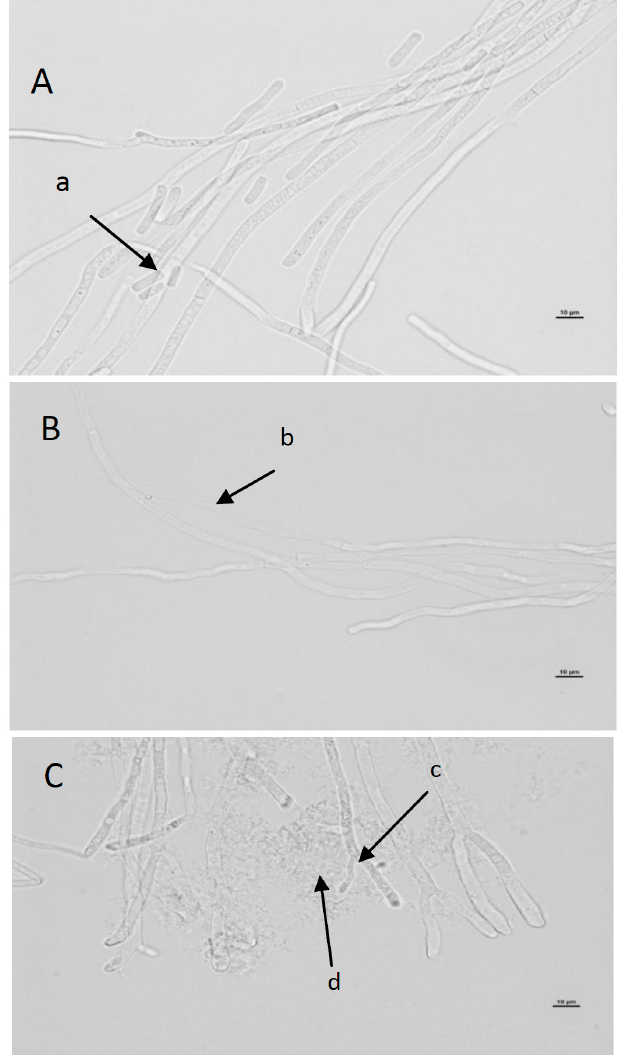
Figure 4. Morphology of the hyphae of Geotrichum candidum cultured in the presence of ellagitannins (REP) on day 6. ( A ) control, ( B ) 5. 0 mg/mL REP, ( C ) 10.0 mg/mL REP. a: arthrospores, b: dehydrated hyphae, c: forked tips, d: hyphal lysis. Scale bar is 10 μ m.